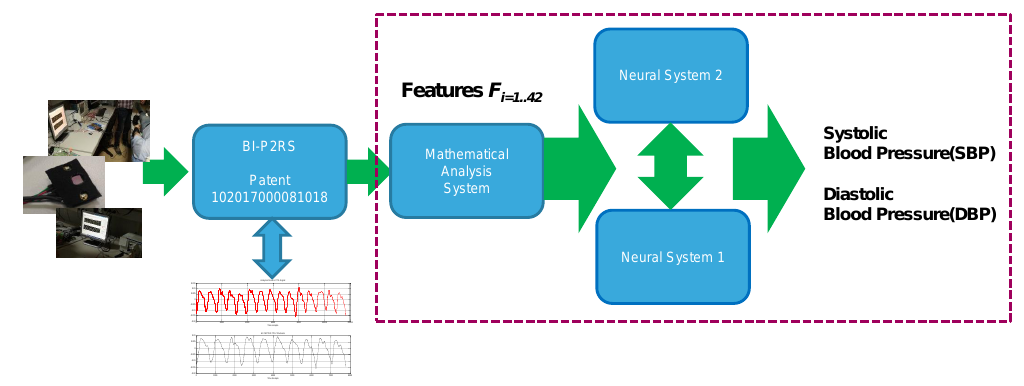
Figure 4. Detailed description of the proposed blood pressure estimation algorithm. BI-P2RS, Bio-Inspired PPG Pattern Recognition System.